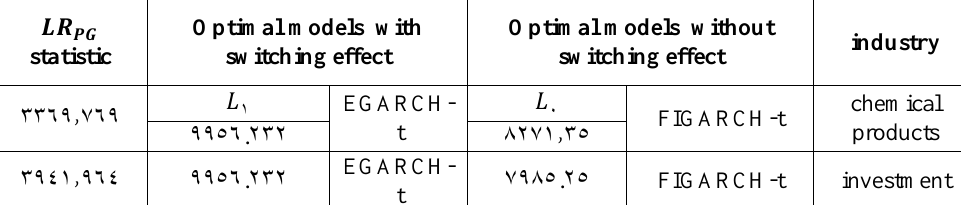
Table 13. Determining the final optimal model for the industries with ARCH